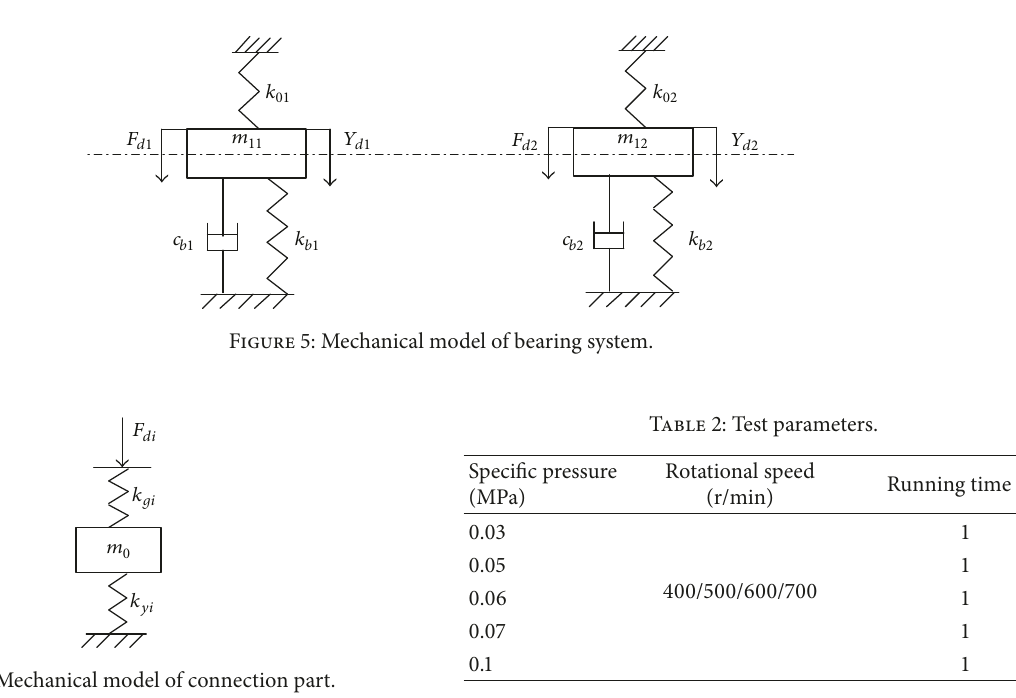
Figure 4: Identification scheme of dynamic characteristic coefficients of water-lubricated rubber bearings.